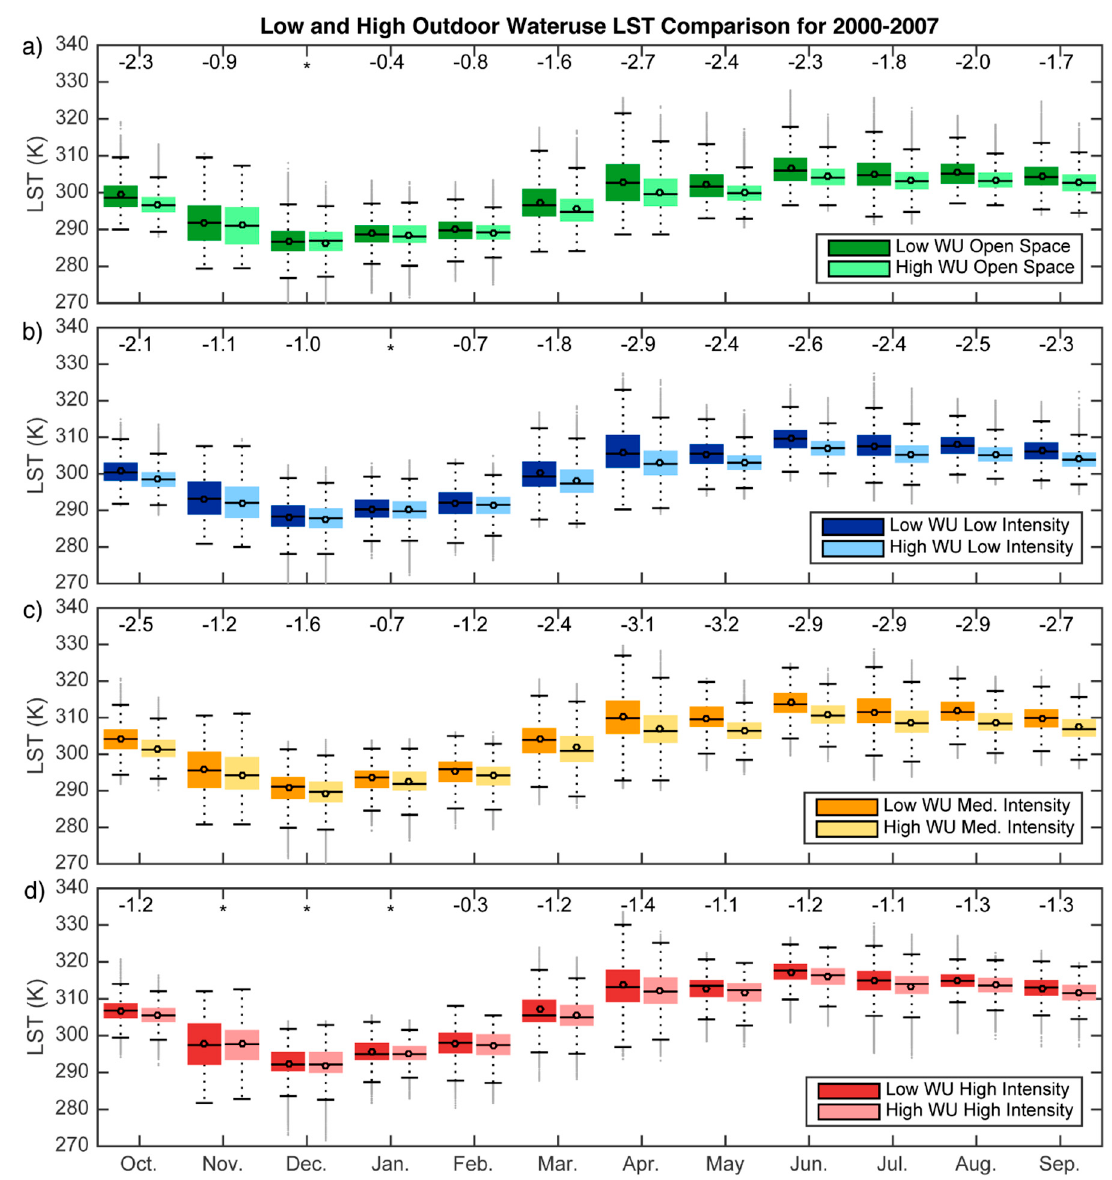
Figure 2. Box plots of monthly LST pixels aggregated across years for ( a ) Developed, Open Space, ( b ) Developed, Low Intensity, ( c ) Developed, Medium Intensity, and ( d ) Developed, High Intensity land cover. The box represents the middle 50% of data, line and circle within the box are the median and mean respectively, the whiskers encompass 96% of the data, and the points are outliers. Mean difference between urban land cover in low (dark color) and high (light color) water use areas for pre-water use restriction years (1/2000 through 12/2007) is shown above the box plot for each month. All mean differences are significant ( p < 0.01) except for those with an asterisk